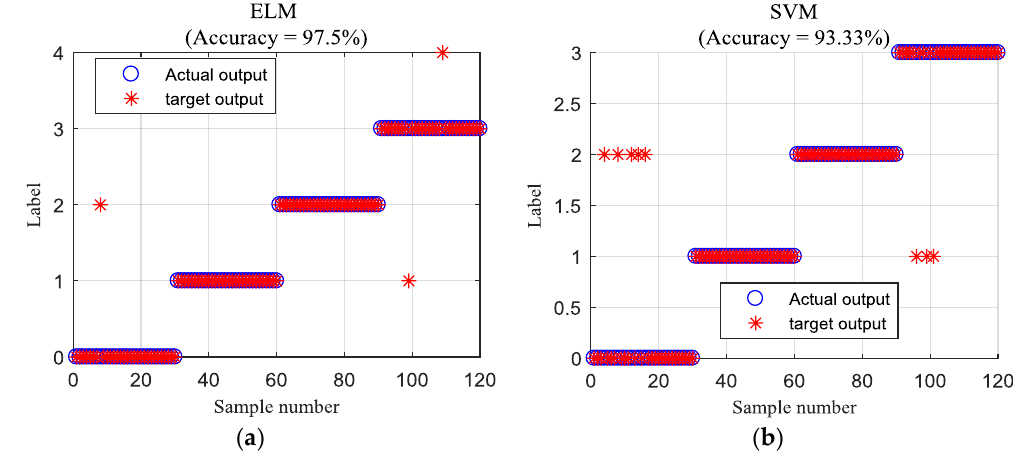
Figure 13. The classification results of ( a ) ELM; ( b ) SVM.